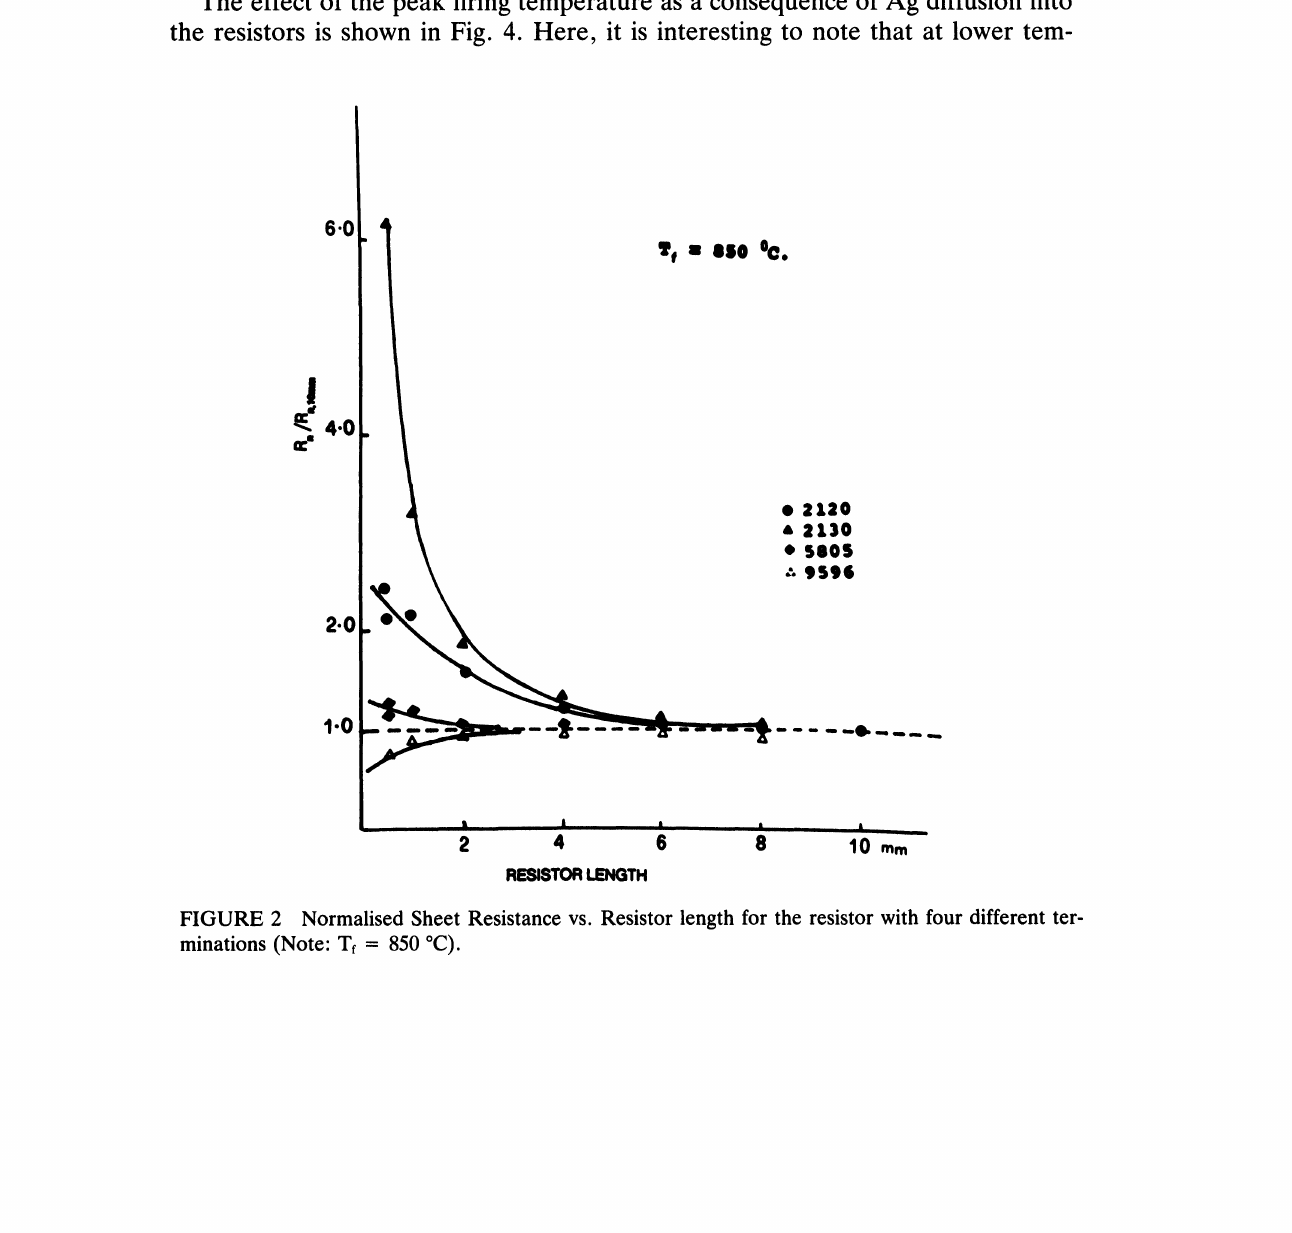
FIGURE 2 Normalised Sheet Resistance vs. Resistor length for the resistor with four different ter- minations (Note: Tf 850